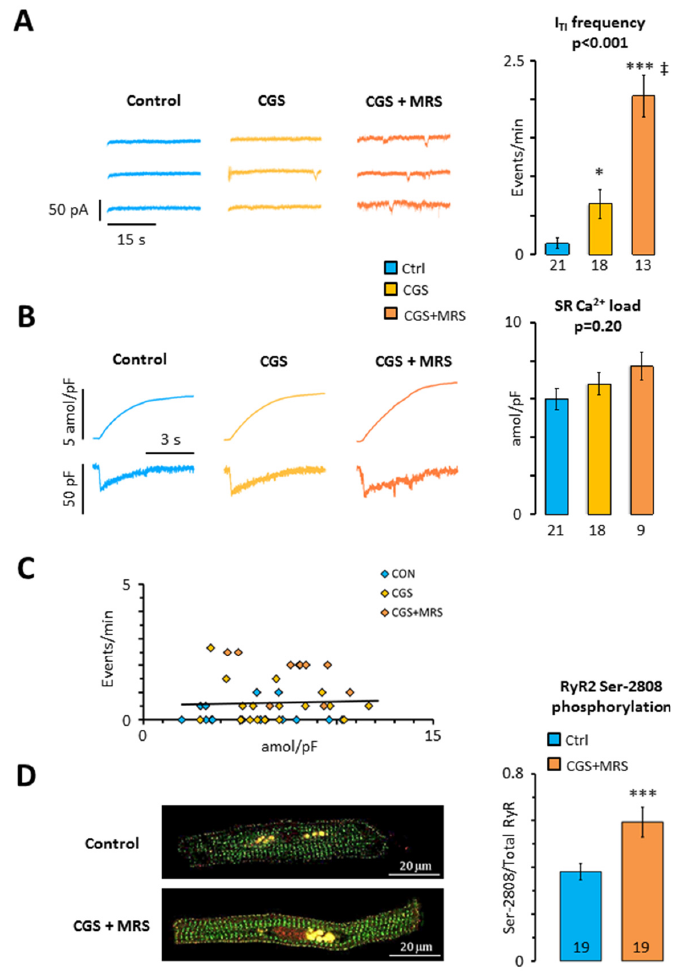
Figure 3. Impact of crosstalk between A 3 R and A 2A R on SR calcium homeostasis. ( A ) I TI frequency; ( B ) SR calcium load; ( C ) relationship between I TI frequency and SR calcium load. Data were recorded in 21 myocytes from 19 patients before (blue) and after perfusion of myocytes with CGS21680 (yellow) and CGS21680 and MRS1191 (orange); ( D ) RyR2 s2808 phosphorylation in 106 myocytes from 19 patients. Significant differences between the control and treatments are indicated with * p < 0.05; *** p < 0.001, ‡ p < 0.01 for CGS21680 + MRS1191 vs. CGS21680. Data in ( A , B ) were analyzed using ANOVA with Welch’s correction ( p -values are given above the bars) and Games–Howell post-test. Unpaired t -test was used in panel ( D ).